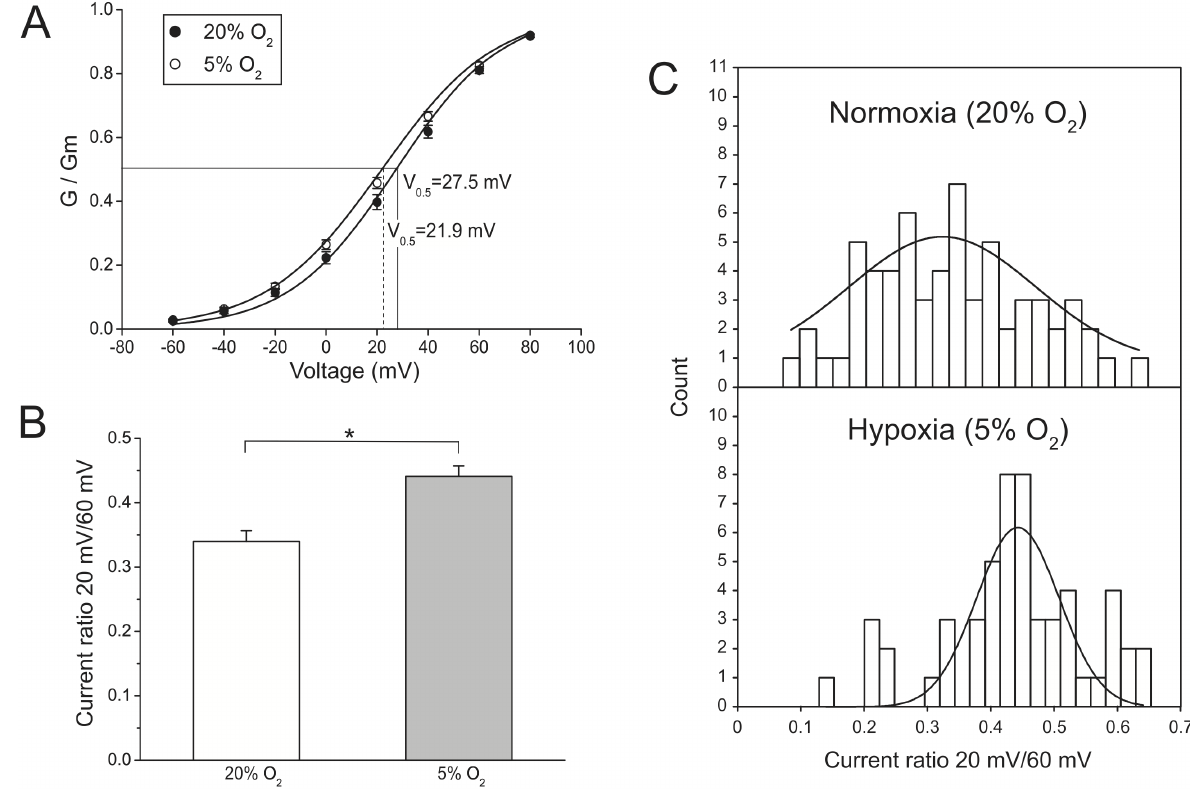
Figure 3. Effect of hypoxia on the activation kinetics and voltage dependence of activation of outward currents. (A) The mean normalized conductance data are presented for normoxic (n=53) and hypoxic cultures (n=47). To obtain the steady-state activation curves, the data were fitted using the Boltzmann sigmoid equation. Hypoxic culture shifted the steady-state activation to the left, indicating that lower voltages were required to open the channels, but the slope factor k was not changed. The potential where activation reached 50% of its maximum ( V 0.5 ) is indicated. (B) The graph shows the average ratio between currents at 20 mV and 60 mV for normoxic and hypoxic cultures. The asterisk (*) denotes a statistically significant difference (p , 0.05). (C) Frequency distribution histograms for the 20 mV/60 mV current ratios. Data were fitted using Gaussian distribution functions.